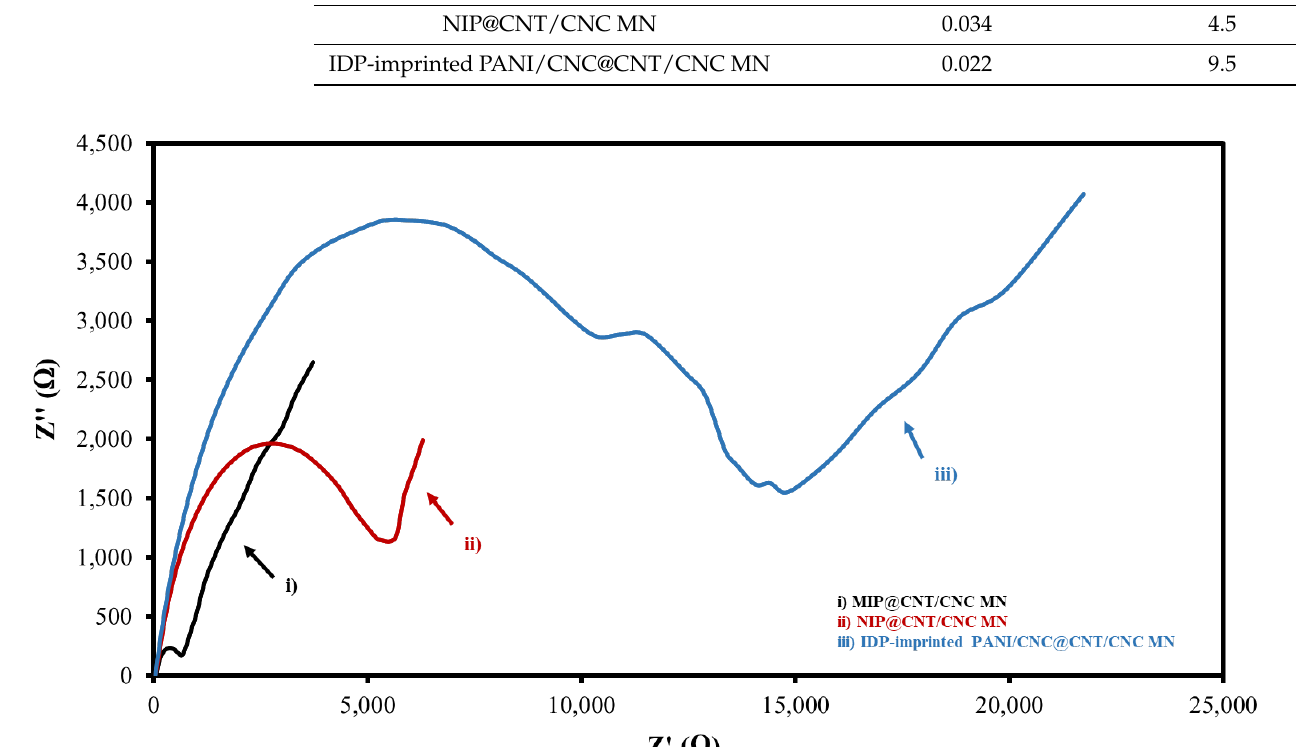
Figure 5. Overlapped Nyquist plot for (i) MIP@CNT/CNC, (ii) NIP@CNT/CNC, and (iii) imidaclo- prid (IDP)-imprinted PANI/CNC@CNT/CNC MN sensors.